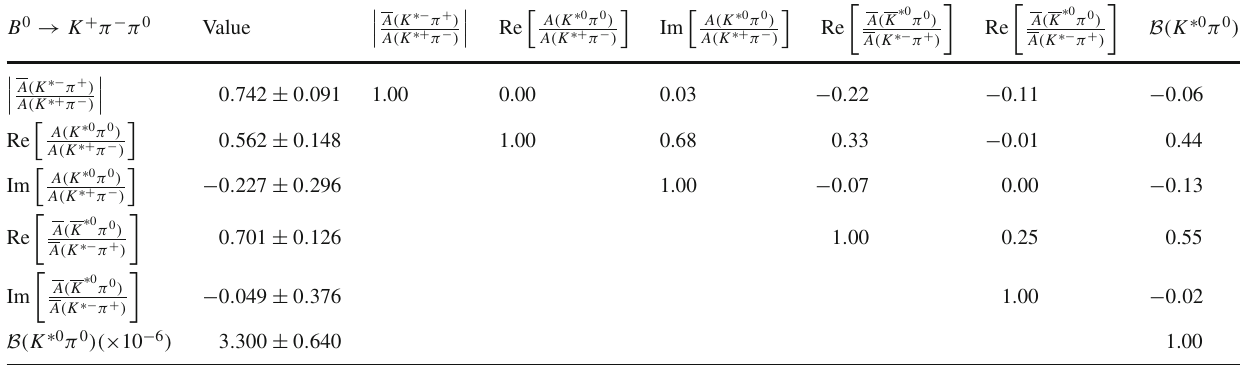
Table 4 Central values and total (statistical and systematic) correlation matrix for observables from the BaBar B 0 → K + π − π 0 analysis B 0 → K + π − π 0